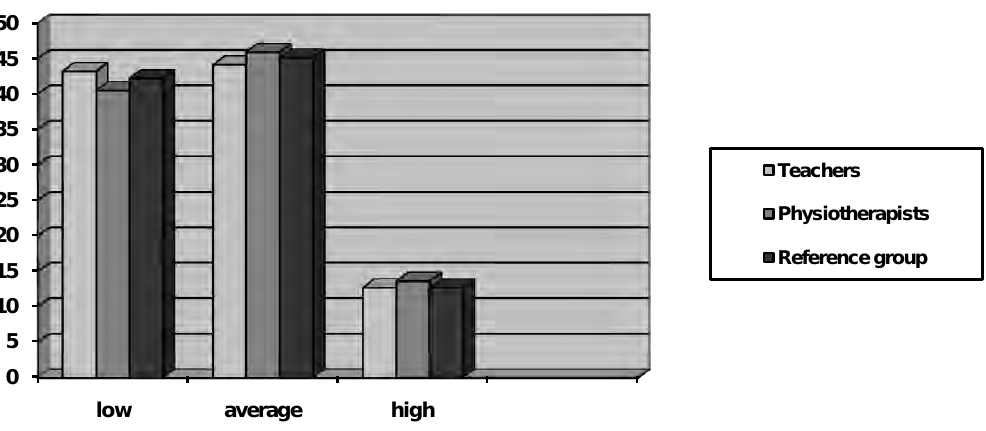
Fig.2. Level of the men’s emotional intelligence and the studies